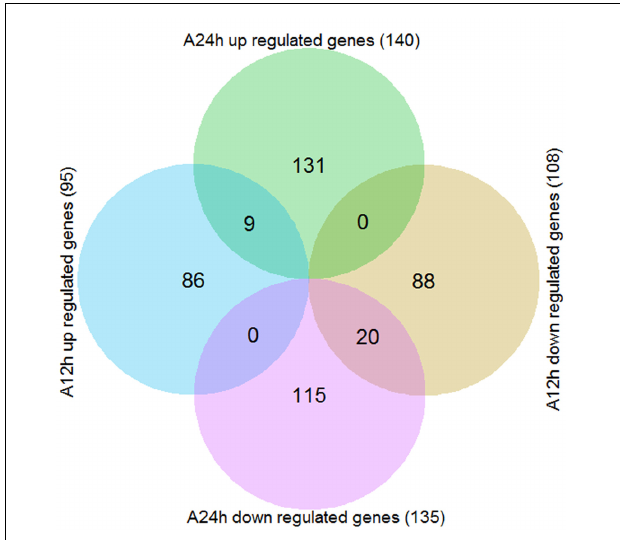
FIGURE 2 | Venn diagram of the differentially expressed genes (DEGs) between alkaline stress (90 mM NaHCO 3 , pH = 8.5) and control. A12h, 12 h of alkaline stress; A24h, 24 h of alkaline